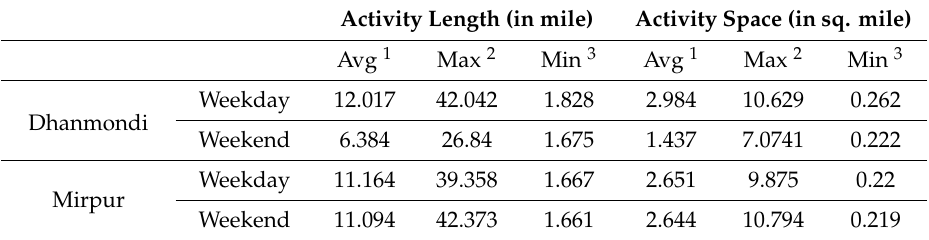
Table 2. Descriptive statistics of household activity length using shortest path network (SPN) method and HH activity space/area using road network buffer (RNB) method.